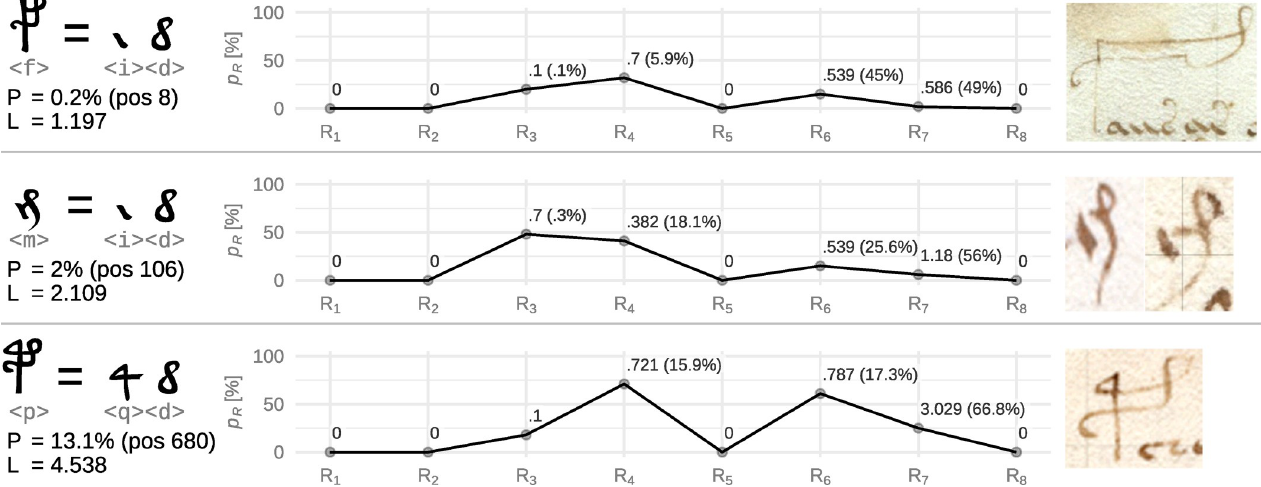
Fig 6. Loss scores of ligature candidates < f > , < m > , and < p > . P stands for the percentage of finding better candidate triplet by its loss score, pos stands for the rank of the loss score, L for the overall triplet loss score L T . Individual rules R are plotted at axis x , probability of finding a better loss score for the given rule is plotted at axis y . Point label contains weighted rule loss R and overall loss contribution of the rule in the brackets. Illustrative among any other triplets, p R n examples of the symbols were taken from (from left-to-right, up-to-bottom): f20v, f108v, f34v, f4v.